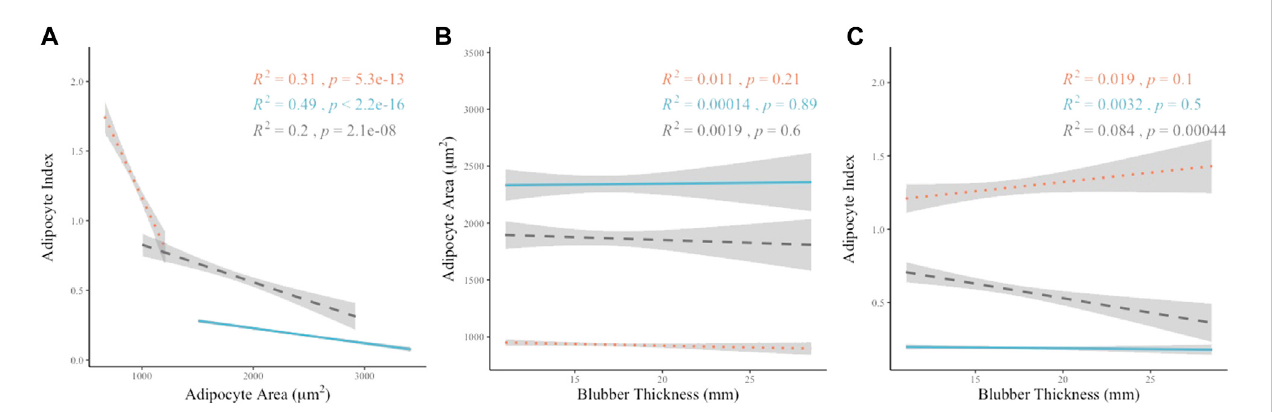
FIGURE 5 Linear correlation relationships between metrics of AA, AI and BT. Blubber layer identi fi ed by color and line shape. Outer layer data shown as orange dotted line, middle layer shown as blue solid line, inner layer shown as gray dashed line. (A) Linear correlations between AA and AI by Pearson ’ s method of correlation (inner R 2 = 0.2, p < 0.01; middle R 2 = 0.47, p < 0.01; outer R 2 = 0.32, p < 0.01). (B) Linear correlations between AA and BT by Pearson ’ s method of correlation (inner R 2 = 0.0019, p = 0.6; middle R 2 = 0.00014, p = 0.89; outer R 2 = 0.011, p = 0.21). (C) Linear correlations betweenAI and BTbyPearson ’ s method of correlation (inner R 2 = 0.084, p = 0.00044; middle R 2 = 0.0023, p = 0.57; outer R 2 = 0.015, p =